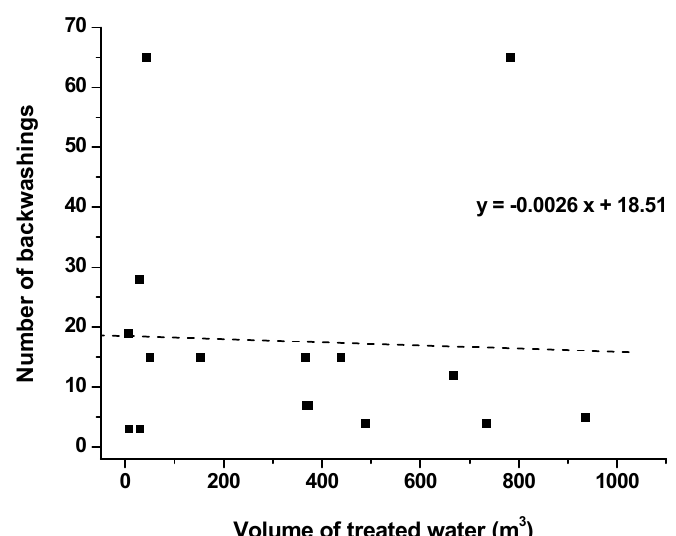
Figure 4. Number of automatic backwashes performed with respect to the treated volume.